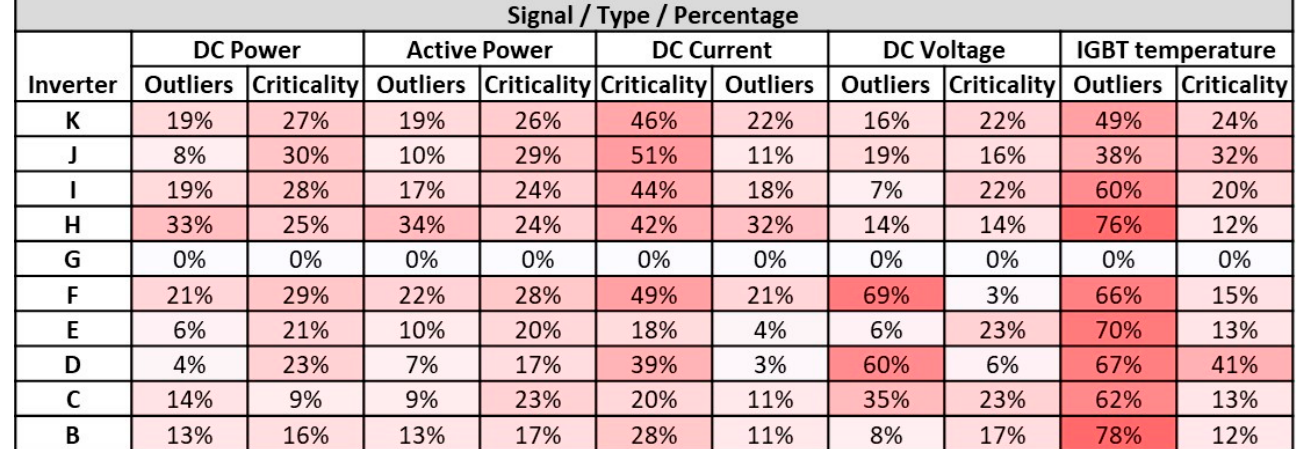
Figure 13. Out-of-normality heatmap (outliers). The heat map shows the criticality (using red color conditional formatting) that describes how much a variable deviates from the mean and the percentage of points detected as outliers in the selected period.